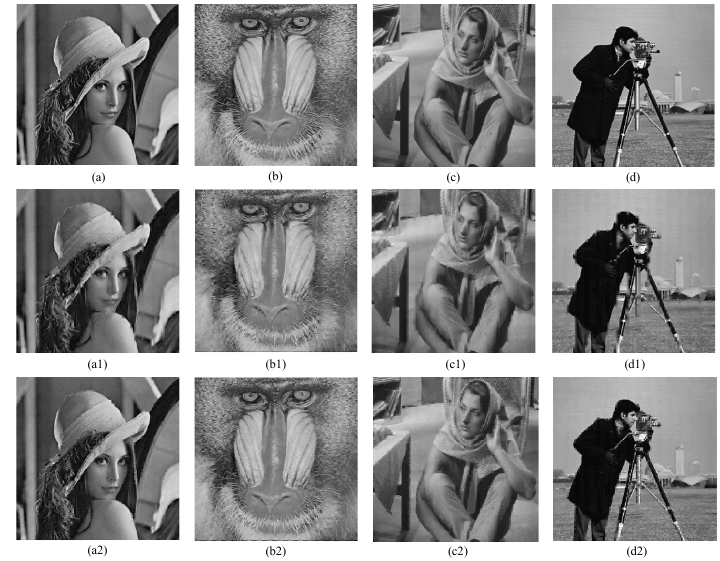
Figure 14. Longitudinal tampering distribution in Lena, Baboon, Barbara and Cameraman (50% tampered): ( a – d ) original images; ( a1 – d1 ) Lee recovered images ( PSNR = 27.17 dB, 28.01 dB, 25.93 dB, and 24.67 dB); and ( a2 – d2 ) proposed recovered images ( PSNR = 29.35 dB, 27.14 dB, 30.12 dB, and 29.80